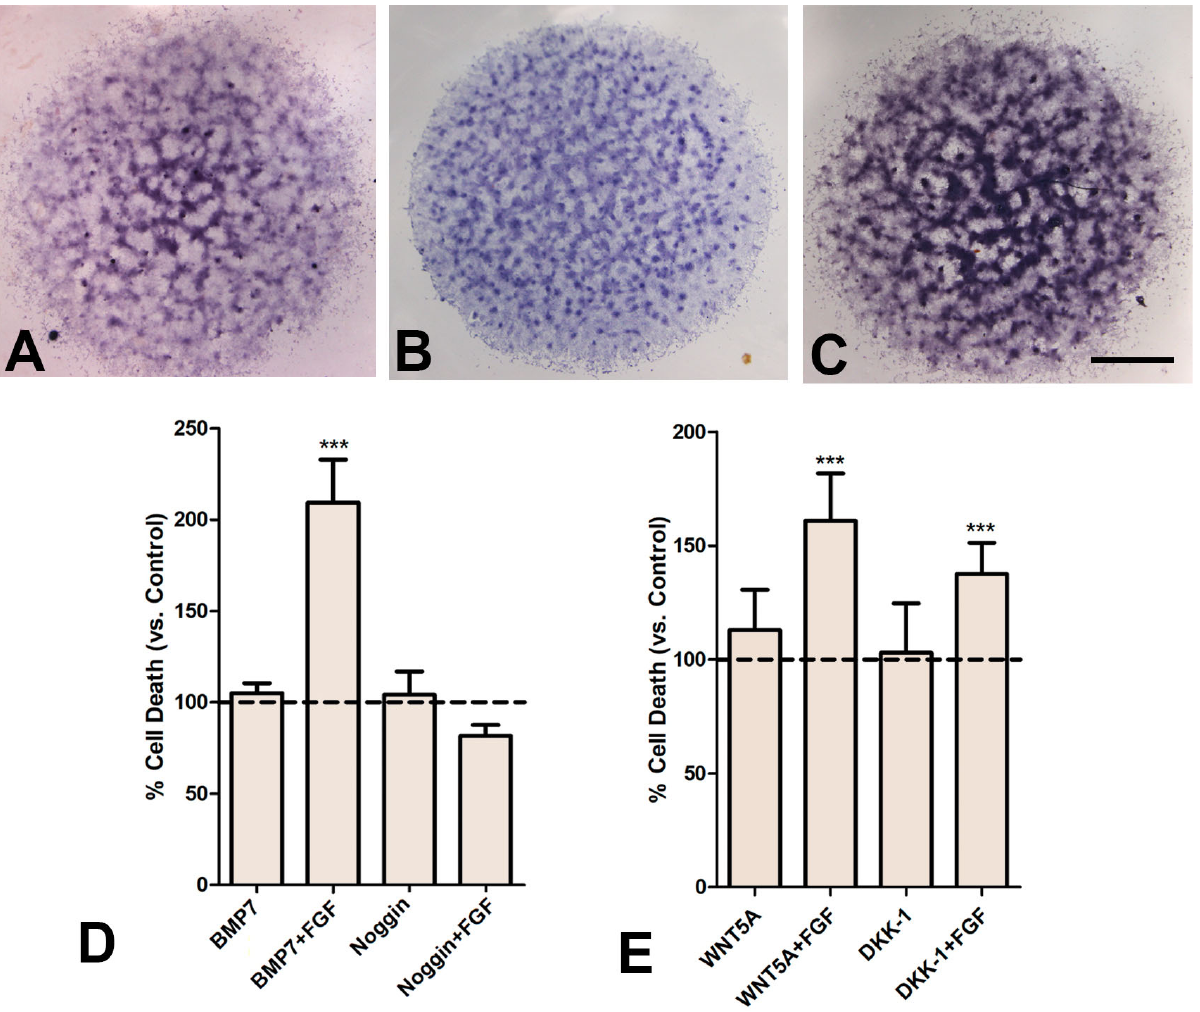
Figure 5. ( A – C ) In situ hybridizations of 2-day-old micromass cultures showing the expression of Bmp7 ( A ), Wnt5a ( B ), and Dkk1 ( C ). ( D ) Graphic representation of the rate of cell death evaluated by flow cytometry in cultures treated for 2 days with BMP7 (200 ng/mL); BMP7 plus FGF2(25 ng/mL);